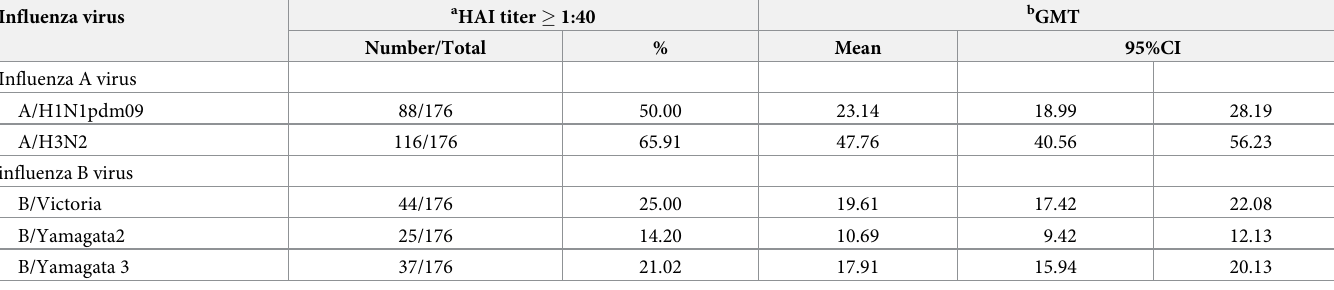
Table 1. Geometric means titers against seasonal influenza virus and seroprevalence among the elderly population. Influenza